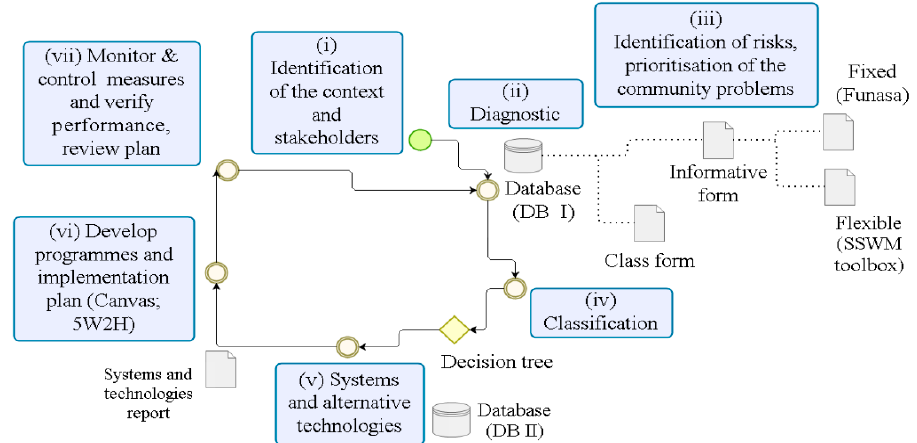
Figure 1. Modules of the sustainable sanitation management tool.